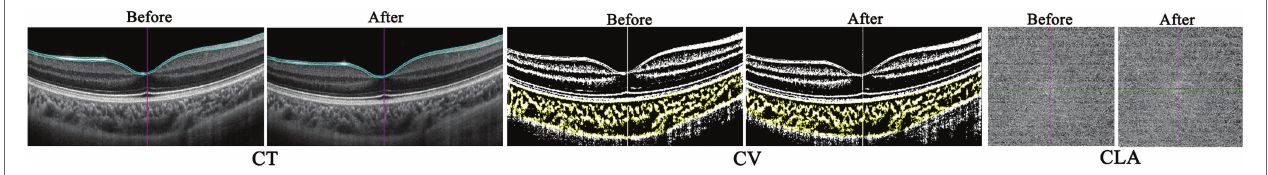
FIGURE 4 | The representative optical coherence tomography (OCT) and OCT angiography (OCTA) images of one myopic eye before and after accommodation.